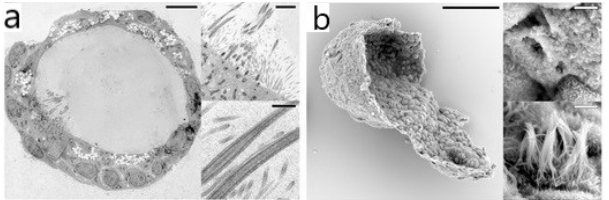
Figure 1. ( a ) TEM image of airway organoid cross section showing the epithelium structure, and details display apical microvilli and cilia with their characteristic microtubule structure. ( b ) SEM image of an airway organoid visualizes its 3D architecture, as well as basal and apical ultrastructure. Details display apical surfaces of secretory and multi-ciliated cells. ( a , b ) are reproduced from [41].